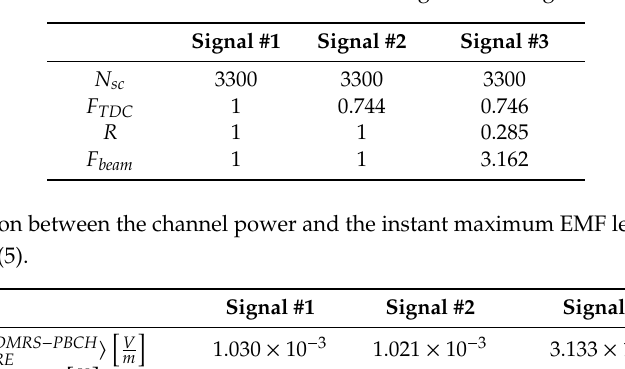
Figure 9. Frame summary with the average received power for the PBCH-DMRS channel. Table 2. Correction factors for the 5G signals investigated.